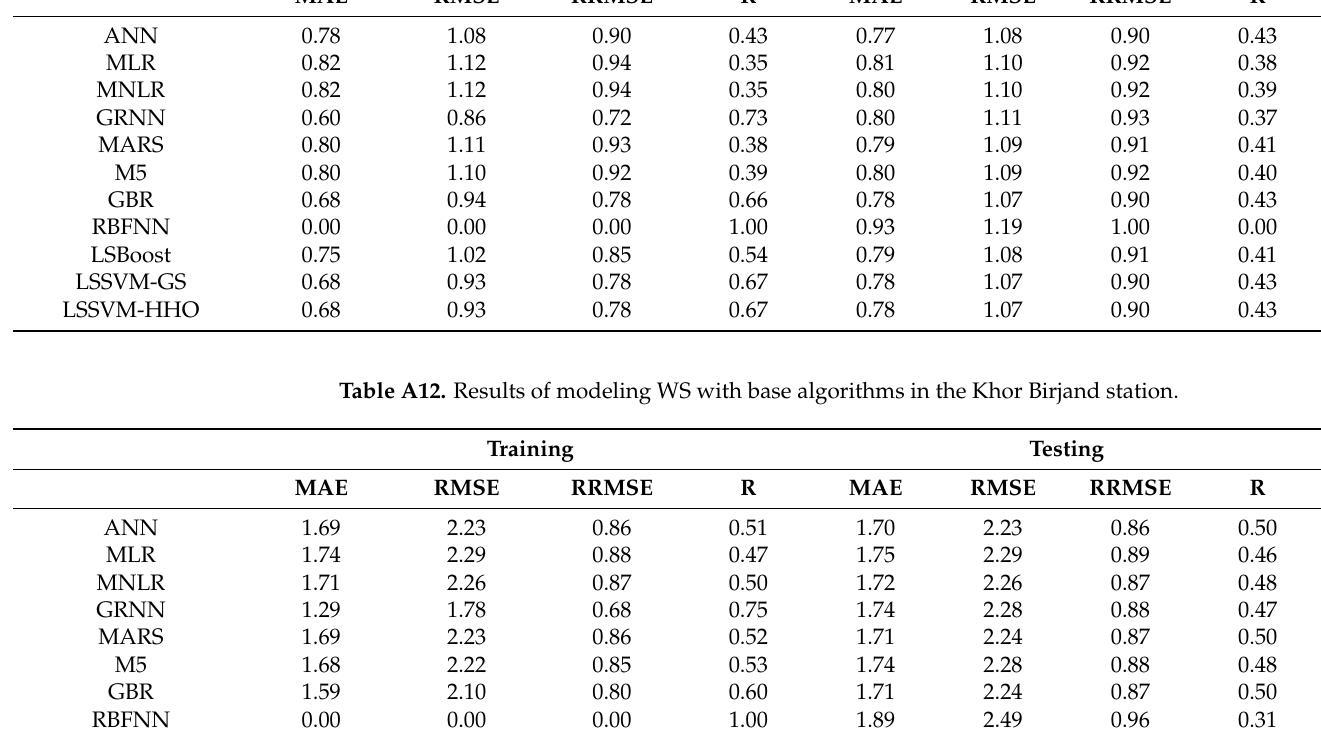
Table A11. Results of modeling WS with the base algorithms in the Boshruyeh station. Training